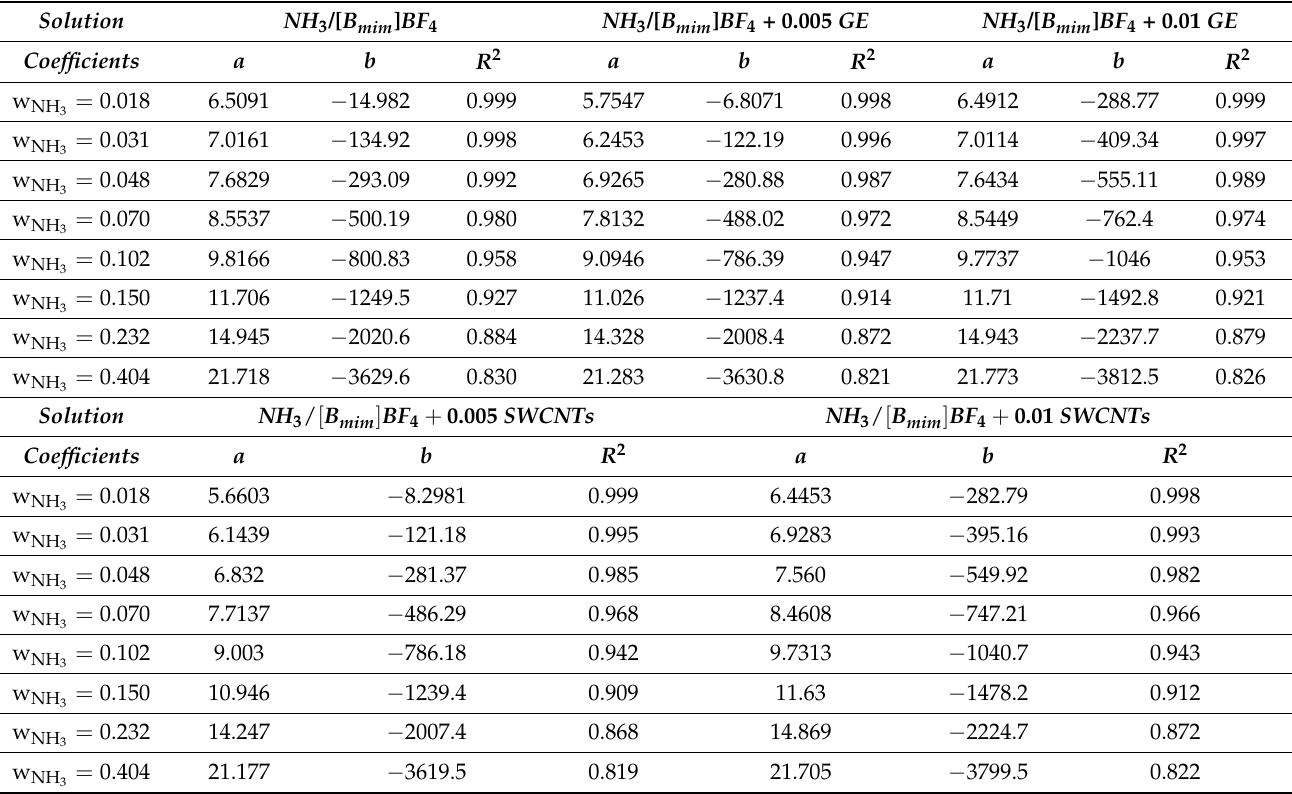
Table 7. Coefficient values a , b , and R 2 obtained by fitting Equation (6).